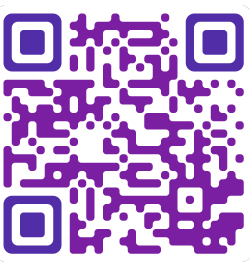
Figure 1. A QR code.